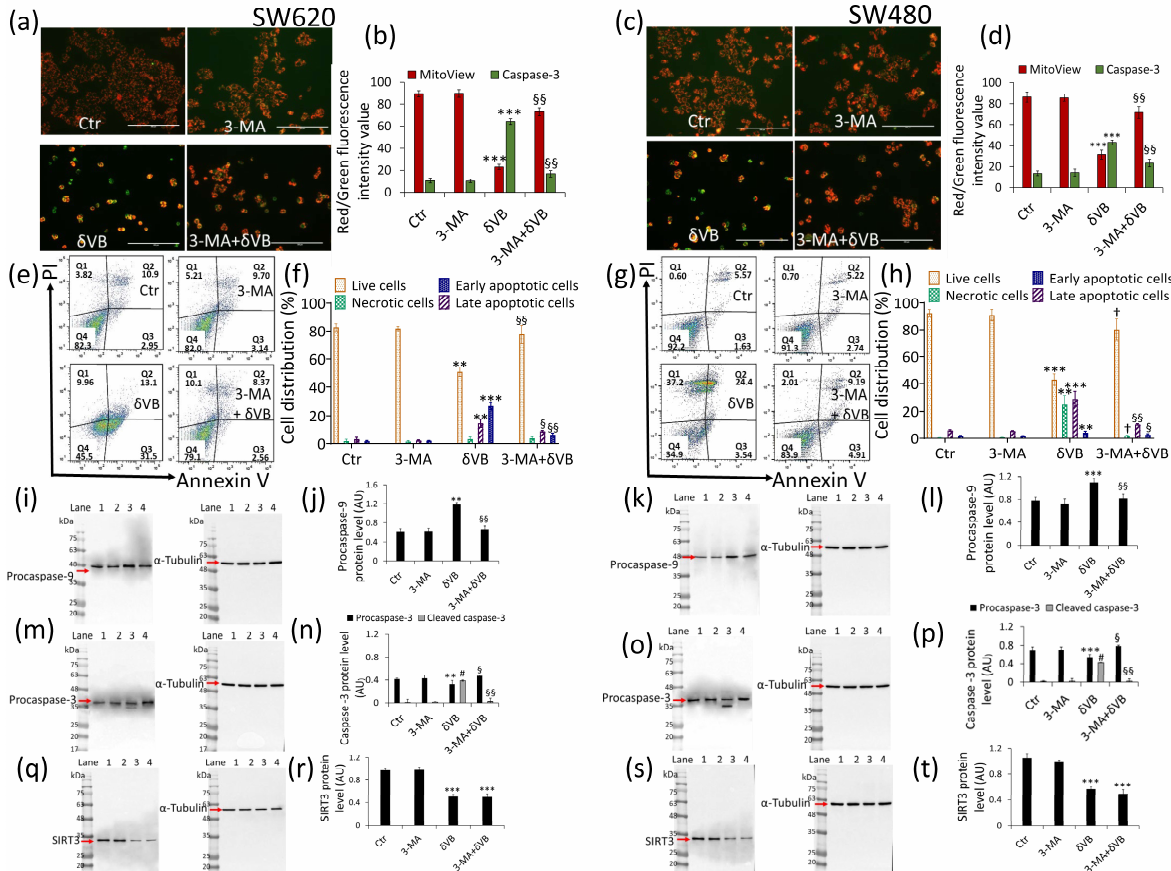
Figure 7. Mitophagy inhibition reduced δ VB-mediated apoptosis. Representative images and analysis of Mitoview 633 (red) and Nucview 488 (green) staining of ( a , b ) SW620 and ( c , d ) SW480 cells. Cells were treated with mitophagy inhibitor 3-MA, δ VB (1.5 mM) or combined 3-MA + δ VB (1.5 mM) for 72 h, as described under Materials and Methods. Results, expressed as red and green fluorescence intensity, were reported as fluorescence intensity value. Scale bar: 100 µ m. Representative dot plots and analyses of annexin V-FITC and PI-stained ( e , f ) SW620 and ( g , h ) SW480 cells. Cell viability/death was assessed by flow cytometry where at least 10,000 events were acquired. Q1: necrotic cells; Q2: late apoptotic cells; Q3: early apoptotic cells; Q4: viable cells. Data are expressed as mean ± SD of n = 3 experiments. Representative full-length blots of Western blotting analysis of procaspase-9 ( i – l ), procaspase-3 ( m – p ) and ( q – t ) SIRT3 protein expression levels in SW620 and SW480 cells. Lane 1 = Ctr; lane 2 = 3-MA; lane 3 = δ VB; lane 4 = 3-MA + δ VB. Before lane 1, molecular weight markers (G266, Applied Biological Materials Inc., Richmond, BC, Canada). Protein expression was calculated, after normalization with α -tubulin as internal control, with ImageJ software and results expressed as arbitrary units (AU). ** p < 0.01 vs.